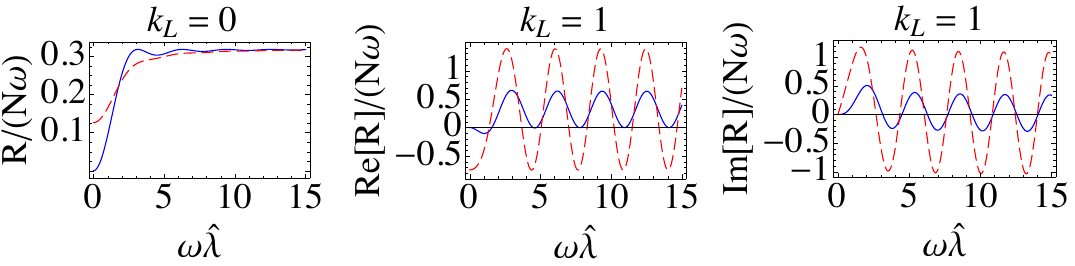
Figure 10 . Microscopic level density for two (cid:13)avors, 2 N f = 2, at the masses Nm 1 = (cid:0) Nm 2 = 0 (blue solid curves) and at Nm 1 = (cid:0) Nm 2 = 1 : 5 (red dashed curves). The left plot shows the level density in the phase k L = 0, see (3.45) , which is the standard situation without or very weak j k j < 0 : 50551 : : : Chern-Simons term. In particular the level density is real and positive. The middle and right plot represent the real and imaginary part of the microscopic level density in the phase k L = 1, cf., eq. (3.49) . Since only the normalization constant in front of the level density changes with k inside this phase (note the unfolding with ! ), we have chosen k = 1. We recall that the imaginary part is an odd function around the origin while the real part is an even